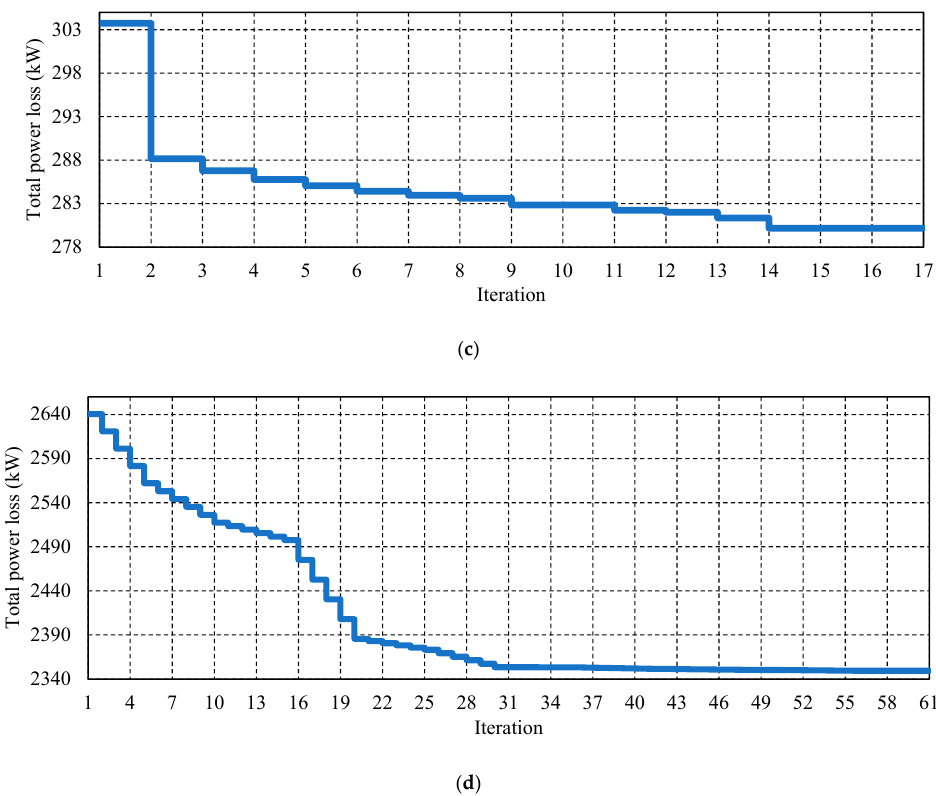
Figure 3. Convergence curves: ( a ) 59-node, ( b ) 69-node, ( c ) 135-node, and ( d ) 415-node.